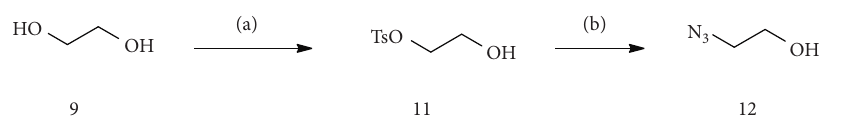
Scheme 3: Synthesis of spacer 12 . Reagents and conditions: (a) tosyl chloride 10 , triethylamine, and DCM; (b) sodium azide, ethanol, and reflux.